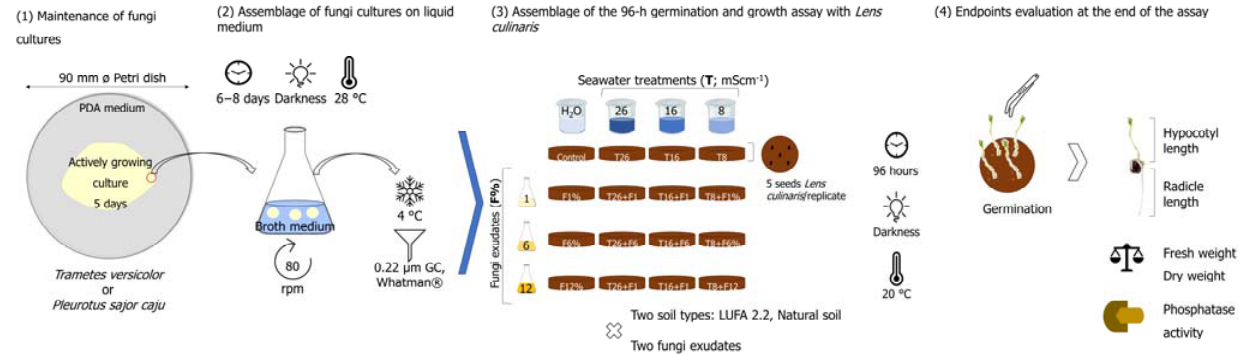
Figure 1. Schematic illustration summarizing the main steps of the methods employed in this study, from the establishment of fungi cultures in a liquid medium, through the experimental setup and finalizing in the endpoints evaluated at the end of the 96-h assay with Lens culinaris .